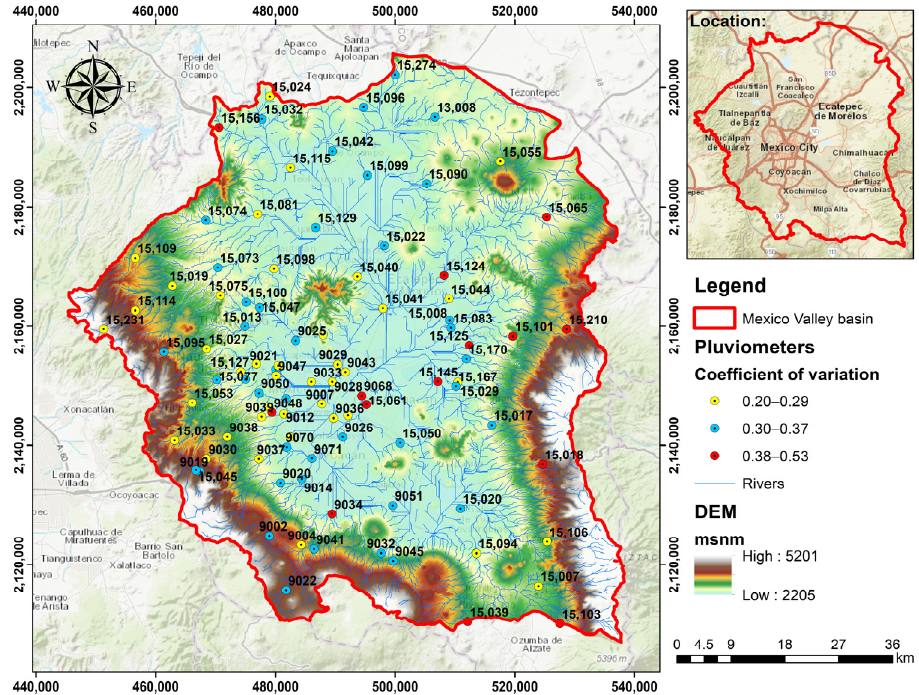
Figure 3. Flash flood hyetograph that occurred in September 2021 in Mexico State, Mexico.